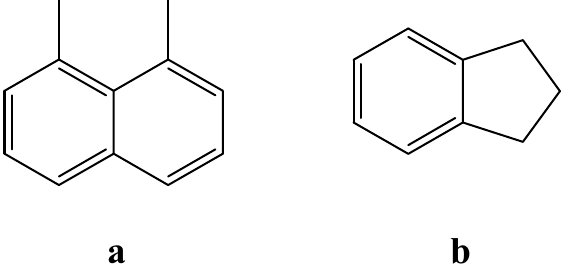
Figure 13. Structure of acenaphthene ( a ) and indane ( b